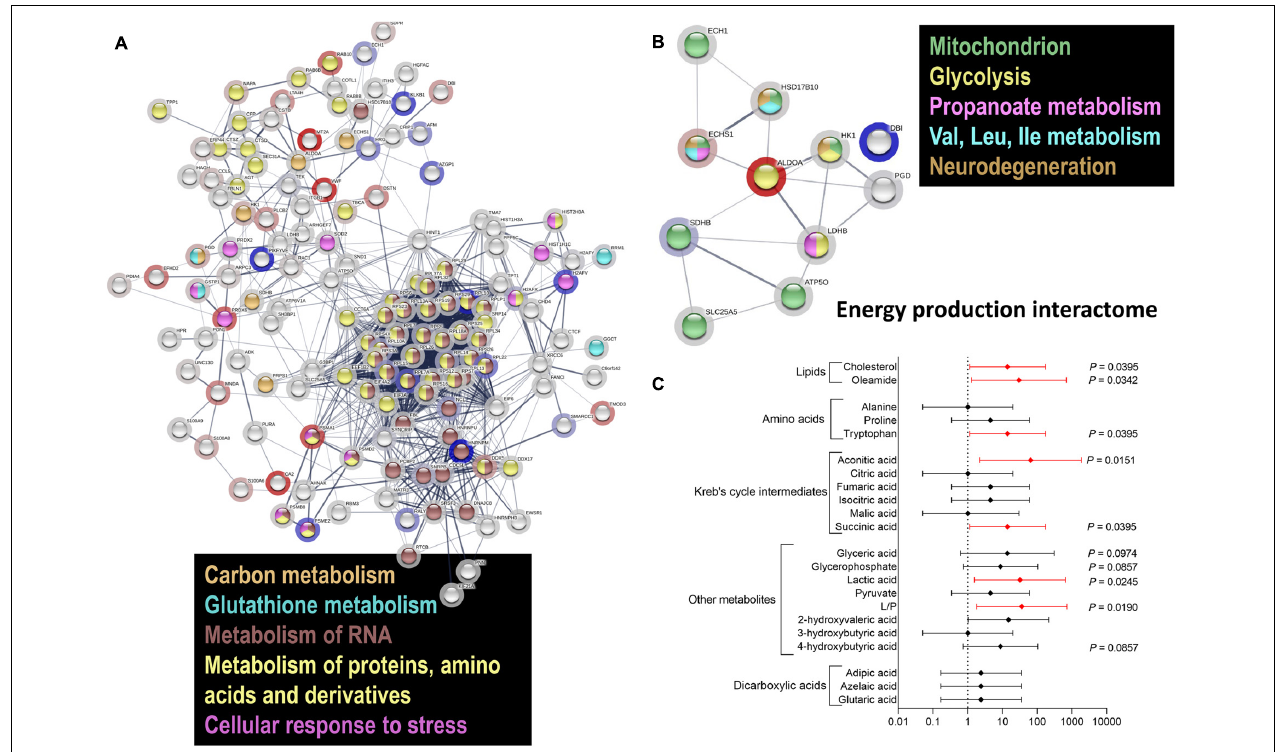
FIGURE 2 | Differential protein and metabolite enrichment in PM females. (A) Proteomics analysis was carried out in PBMC from PM females 29–63 year old and age-matched controls. Proteins detected in both PM and non-carriers were uploaded with their corresponding fold change values (see Supplementary Dataset ) to STRING. Interactomes were algorithmically generated based on direct associations (physical or functional) between eligible proteins. The interactomes are color coded with blue nodes representing proteins that were down-regulated, red upregulated in PM, and clear when there were detected but whose levels were not statistically different between diagnostic groups. The shading of each node is correlated with the magnitude of the fold change. Differentially regulated metabolic pathways included carbon metabolism, metabolism of RNA, proteins, amino acids, and cellular response to oxidative stress. (B) A subset of differentially regulated proteins ( Supplementary Dataset , tabs highlighted in gray) had key roles in mitochondrial function, glycolysis, fatty acid and amino acid metabolism, as well as in RNA processing (pathways reported in Supplementary Figures 1–3 ) and pathways affected in neurodegeneration. (C) Metabolomics analysis was performed in plasma from 8 controls and 7 age-matched PM carriers, 24–52 year, and age-matched controls. Differentially enriched metabolites are shown, with their respective p values, in Supplementary Figure 4 . A forest plot was built with the odds ratios ( X axis) and the 95% CI (error bars) calculated with control values for each selected metabolite based on its role in glycolysis and mitochondrial metabolism. In red are metabolites with statistically significant OR, indicating a higher probability to be affected in the PM, and as such considered as putative biomarkers for female